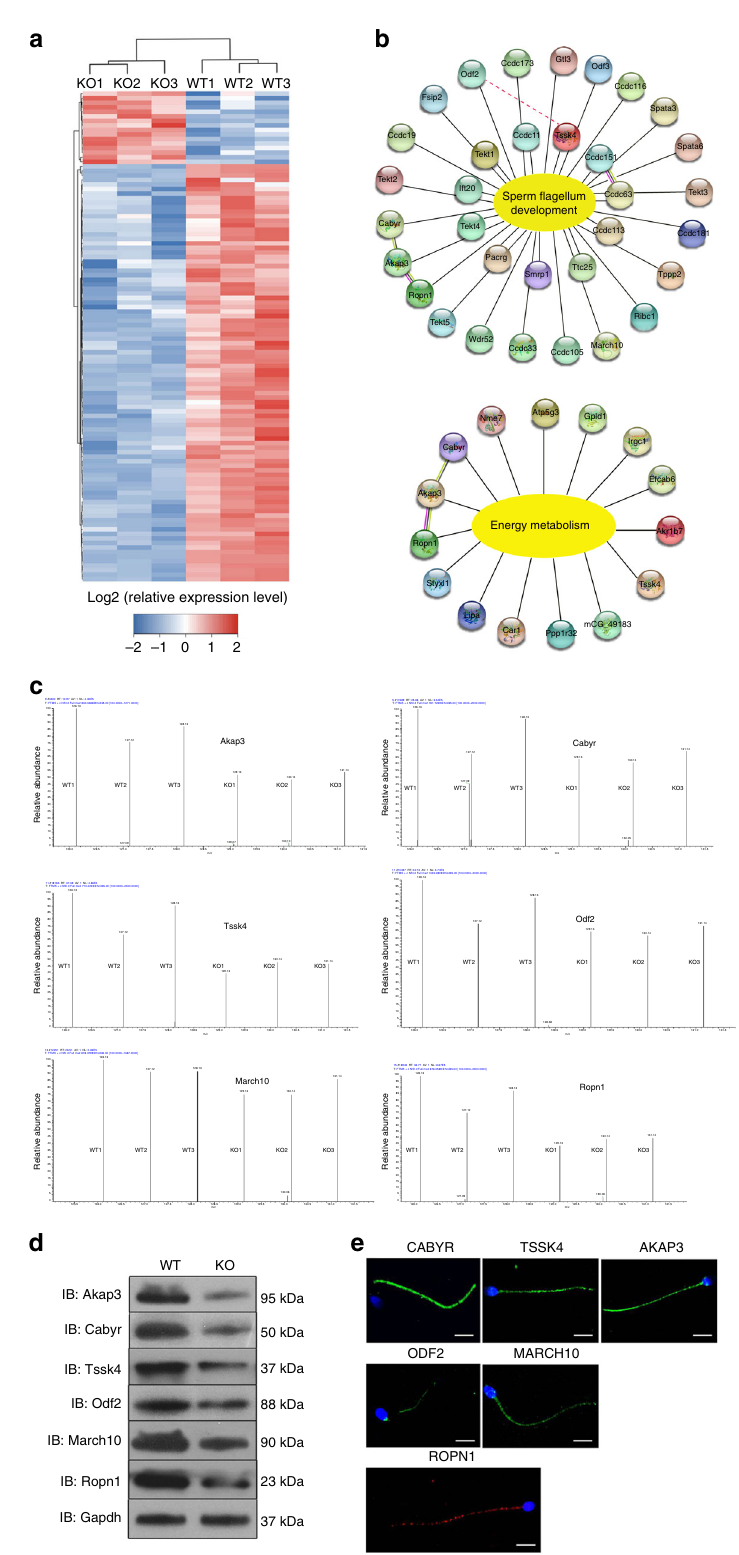
Fig. 5 Proteins for sperm fl agellum development are down-regulated in KO mice. a The heat map from three independent proteomic analyses of testes from the WT and KO mice. b The proteins down-regulated in the KO mice are associated with sperm fl agellum development and related energy metabolism. c The different MS/MS spectra of Akap3, Odf2, Tssk4, March10, Ropn1, and Cabyr in the KO mice and the WT mice. d The expression of the key proteins in the testes of the WT and KO mice. The western blotting results con fi rmed the decreased expression of Akap3, Odf2, Tssk4, March10, Ropn1 and Cabyr in the KO mice compared with the WT mice. ( n = 4 biologically independent WT mice or KO mice). e The location of the vital proteins in human spermatozoa by immuno fl uorescence staining. AKAP3 (green), ODF2 (green), TSSK4 (green), MARCH10 (green), CABYR (green), and ROPN1 (red) are dominantly expressed in human spermatozoa fl agella. (blue, DAPI; scale bars, 5 µ m) NATURE COMMUNICATIONS|